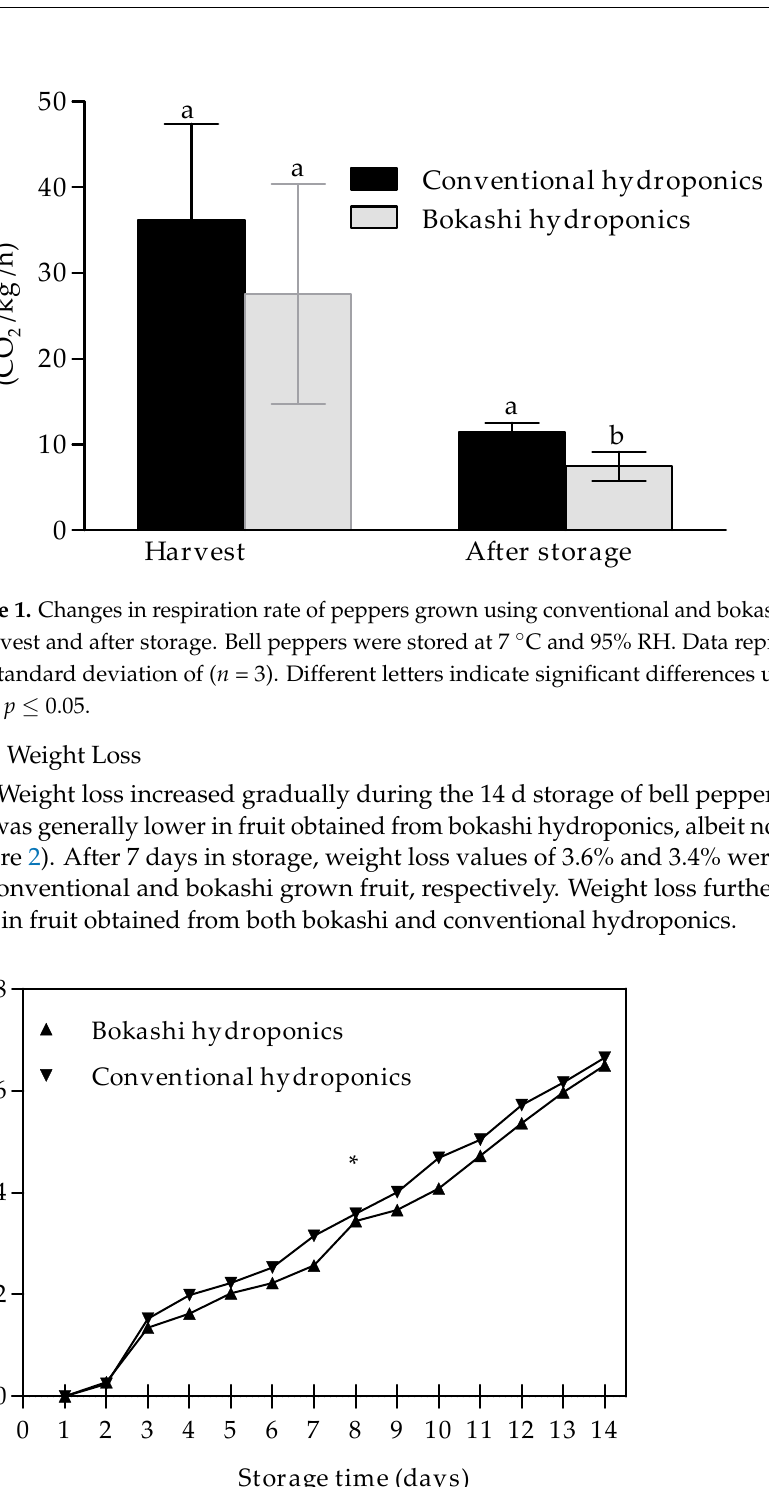
* Data represent the mean and standard deviation ( n = 5). Different letters in each column indicate significant differences between treatments either at harvest or after storage using t -test two tail at p ≤ 0.05. * = significant, there are significant differences between harvest and after 14 d storage. ns = non-significant, there are no significant differences between har- vest and after 14 d storage. After a 14 day storage period, a significant contrast was observed between the two treatments. There was a decrease in L* value for conventional and bokashi grown red-ripe fruit, although the change was not significant for conventionally grown fruit (Table 5).